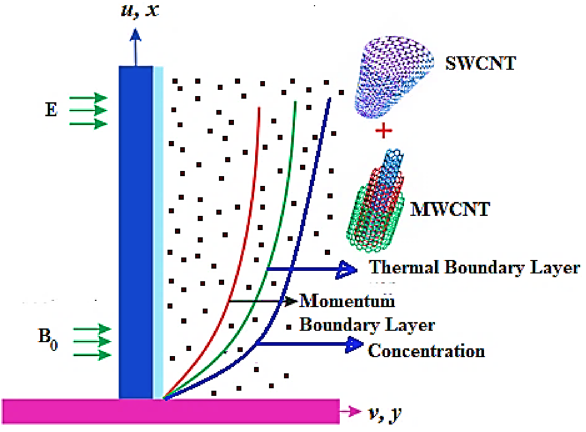
Figure 1. Geometry of the